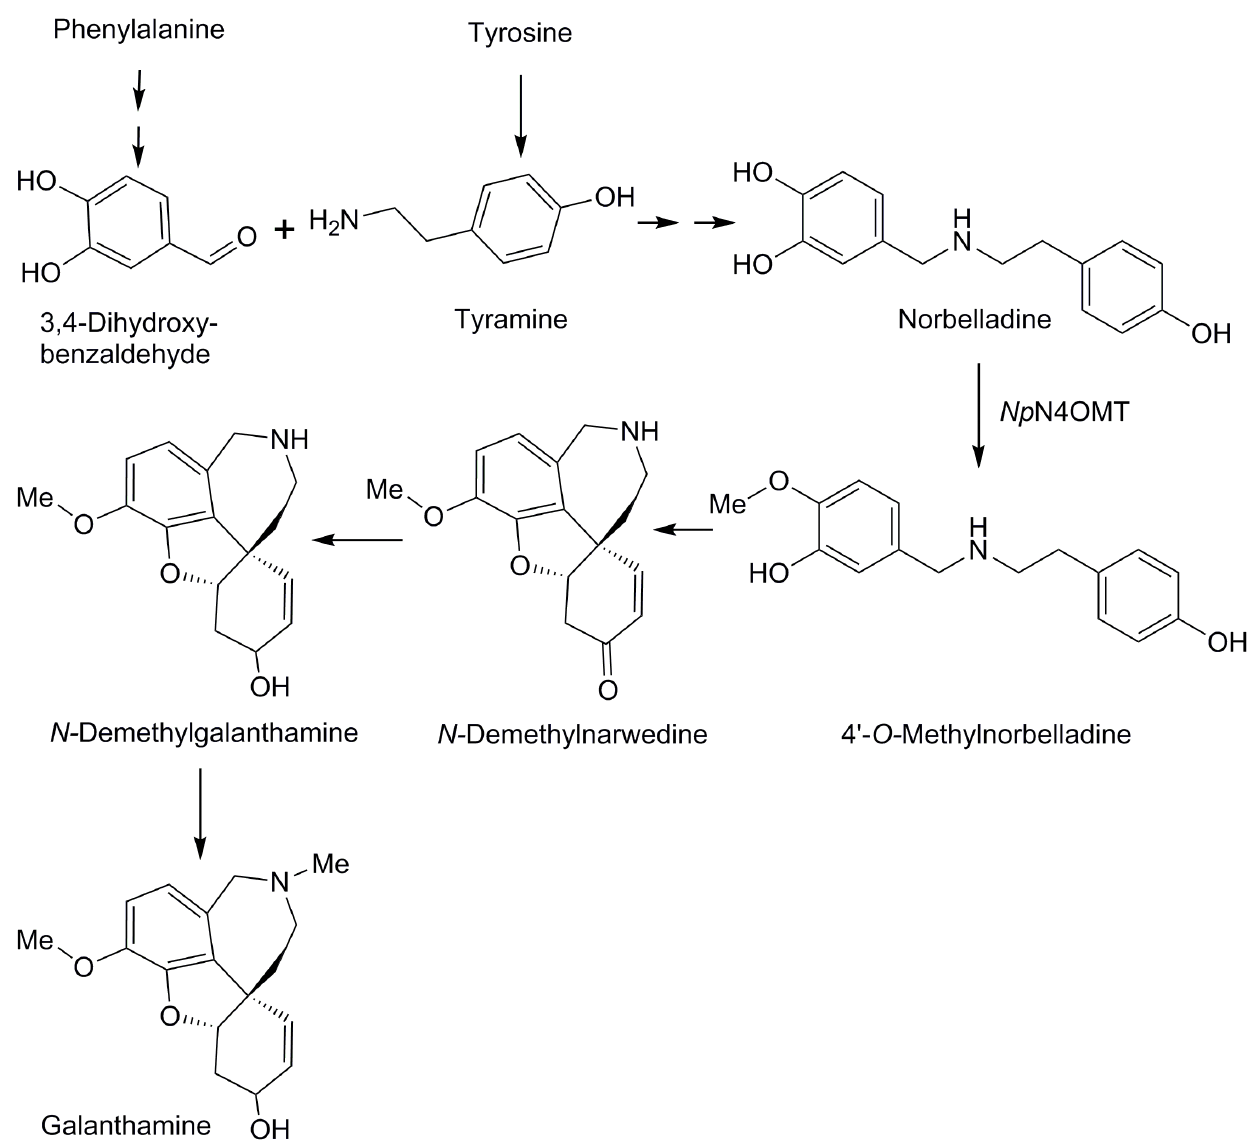
Figure 1. Proposed biosynthetic pathway for galanthamine. 3,4-Dihydroxybenzaldehyde derived from phenylalanine and tyramine derived from tyrosine are condensed to form norbelladine. Norbelladine is methylated by Np N4OMT to 4 9 - O- methylnorbelladine. 4 9 - O- Methylnorbelladine is oxidized to N- demethylnarwedine. N- demethylnarwedine is then reduced to N- demethylgalanthamine. In the last step, N- demethylgalanthamine is methylated to galanthamine.